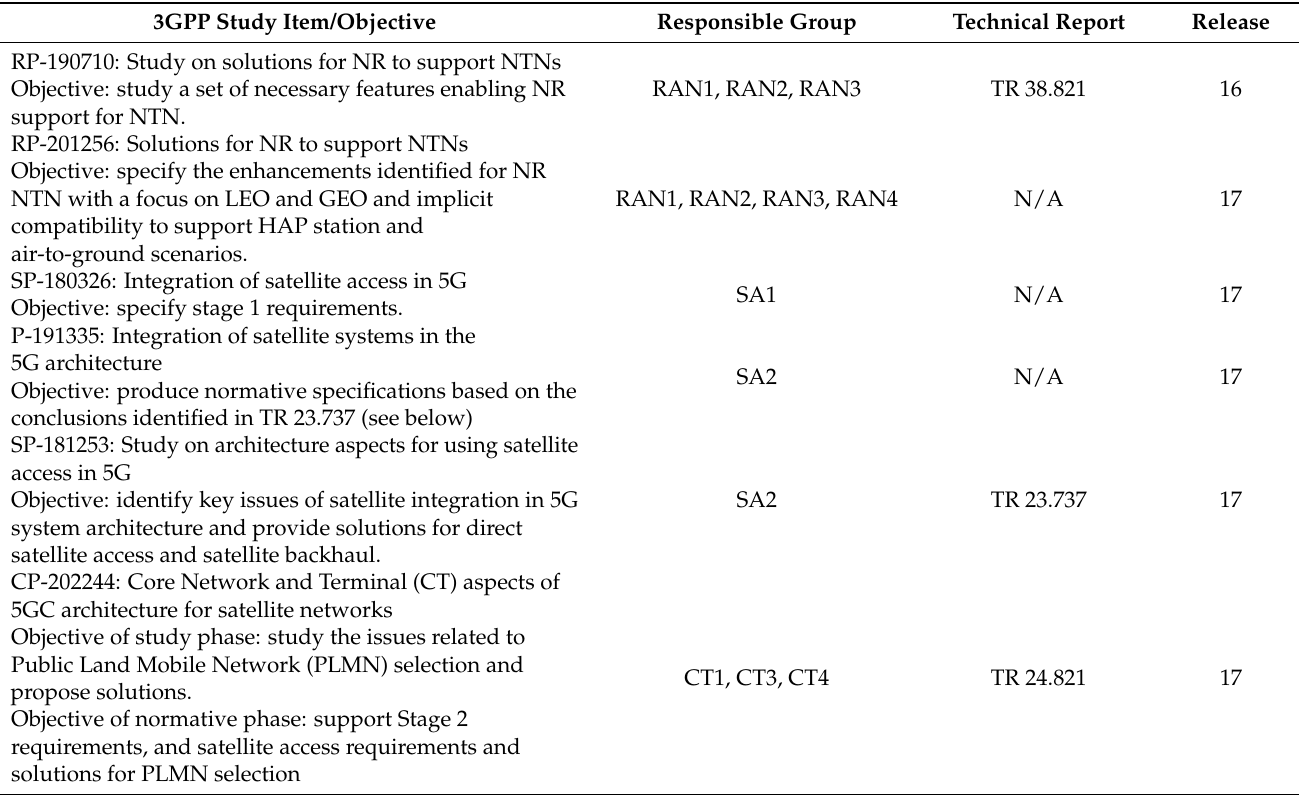
Table 1 provides a list of 3GPP-NTN Technical Reports extracted from [8]. Table 1. Related 3GPP-NTN Technical Reports (Extracted from